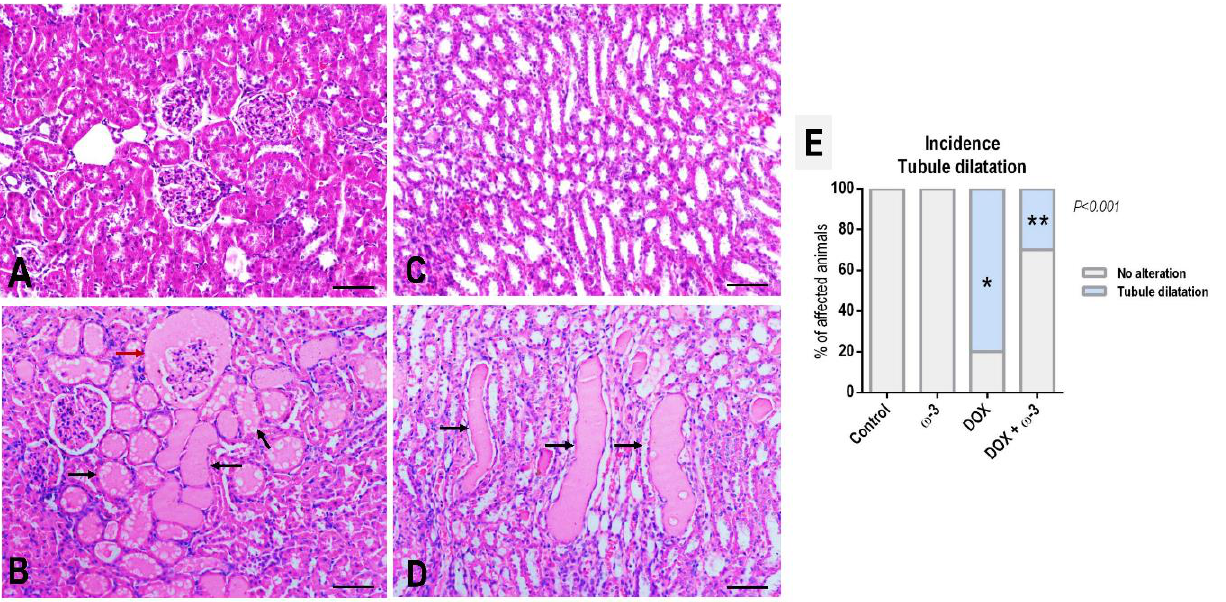
Figure 2. Representative photomicrographs of hematoxylin and eosin (HE)-stained sections of the ( A , B ) cortical and ( C , D ) medullar regions of the kidney of vehicle-( A , C ) and ( B , D ) DOX-treated rats (scale bar: 100 µm). DOX-treated rats showed focal areas of tubular dilatation in both cortexes (black arrows), including Bowman’s space (red arrow) and medulla (black arrows), due to the appearance of hyaline (or eosinophilic proteinaceous) casts in the lumen of tubules. ( E ) Effects of omega 3 ( ω -3) supplementation on doxorubicin (DOX)-induced effects on the incidence of kidney tubular dilatation. N = 10 rats/group. Male Wistar rats received ω -3 (400 mg/kg body weight/day) by intragastrical administrations for six weeks (or vehicle). After two weeks of ω -3 supplementation, animals received weekly single intraperitoneal injections of DOX (3.5 mg/kg body weight) for four weeks (or vehicle). * Statistical difference compared to the control group by Fisher’s Exact test ( p < 0.05). ** Statistical difference compared to DOX group by Fisher’s Exact test ( p <